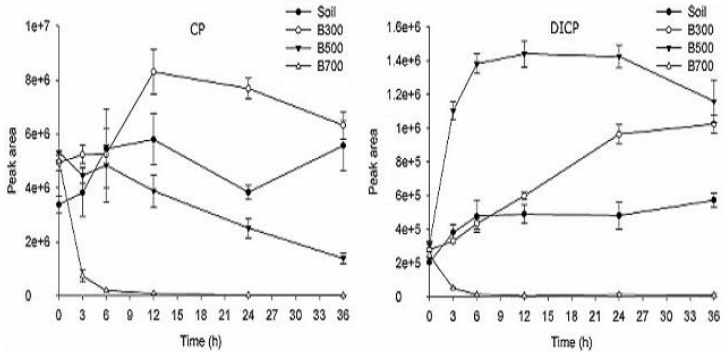
Figure 7. CP and dichloronitromethane (DICP) concentrations in soil and biochar. The peak areas of CP and DICP were used to express the changing concentrations. The significant difference of values in each biochar was determined using a 95% confidence interval around the estimates ( p < 0.05). The CP in B500 and soil was not significantly different, but there was a significant difference in B300 and B700. The differences of DICP were considered significant in different biochar and soil.